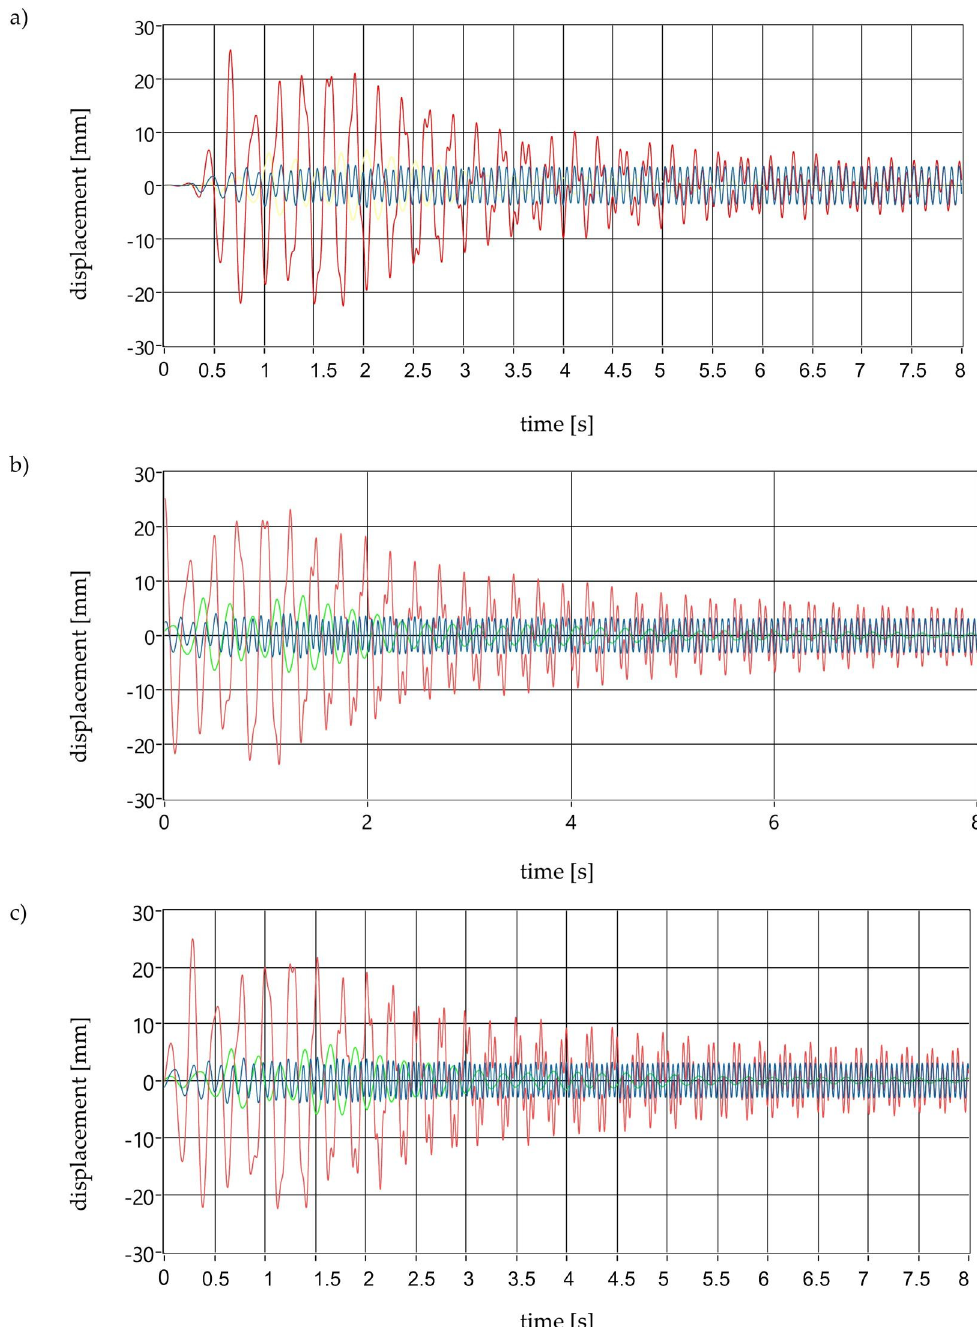
Figure 9. Time course of the old drive’s vibration amplitude measured at point 1L (direction y-red, x-blue, z-green) during start-up for rated frequency: ( a ) f = 13.2 Hz; ( b ) f = 16.5 Hz; ( c ) f = 19.8 Hz.